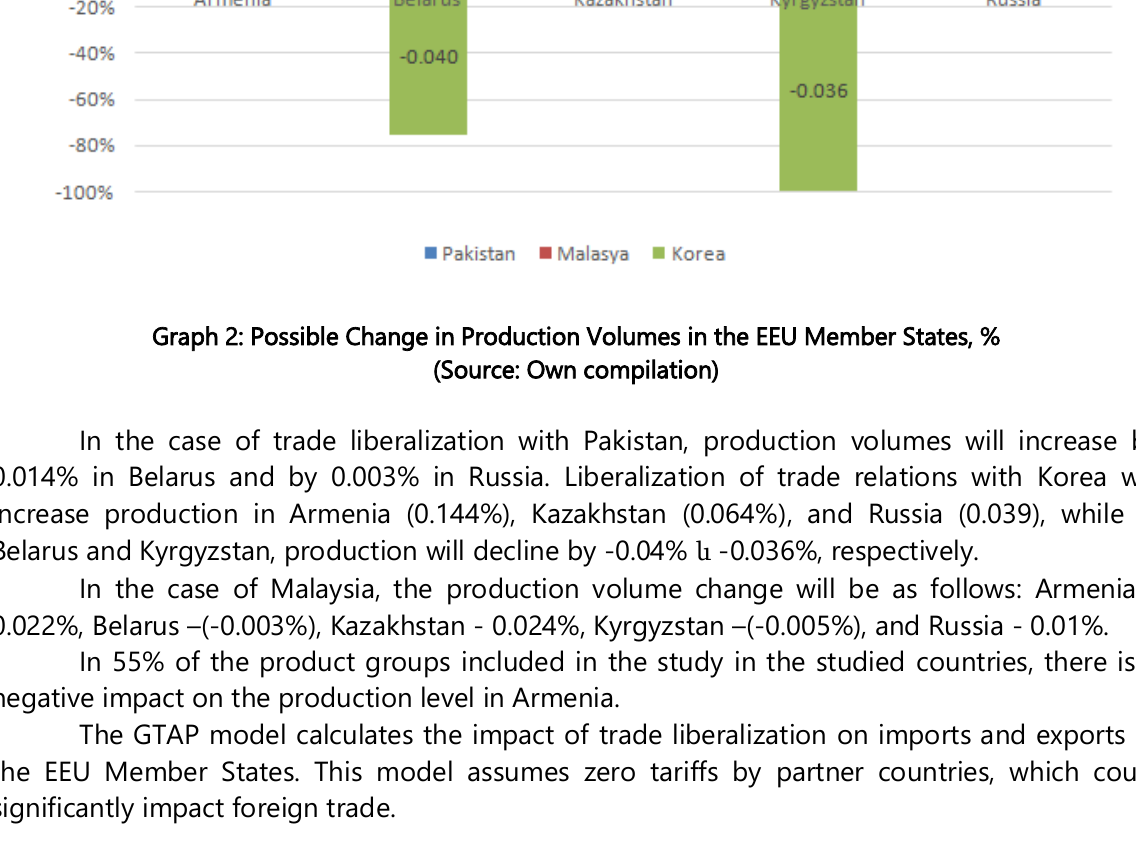
Table 2: Relative Changes in the Volume of Imports in the EEU Member States, % (partner country Pakistan) (Source: Own compilation) GTAP Model